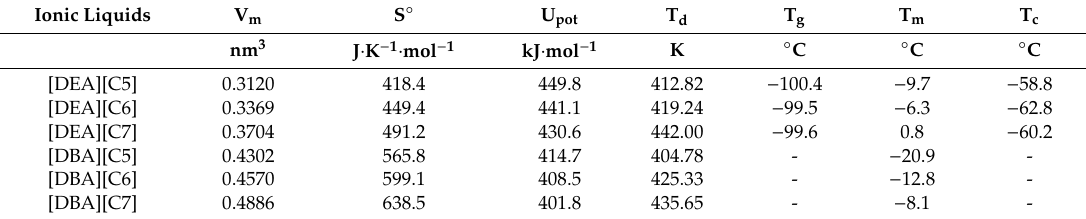
Table 6. Molar volume, V m ; standard entropy, S ◦ ; lattice potential energy, U pot ; thermal decomposition, T d ; glass transition, T g ; melting point, T m ; crystallization point, T c . V m , S ◦ and U pot were calculated